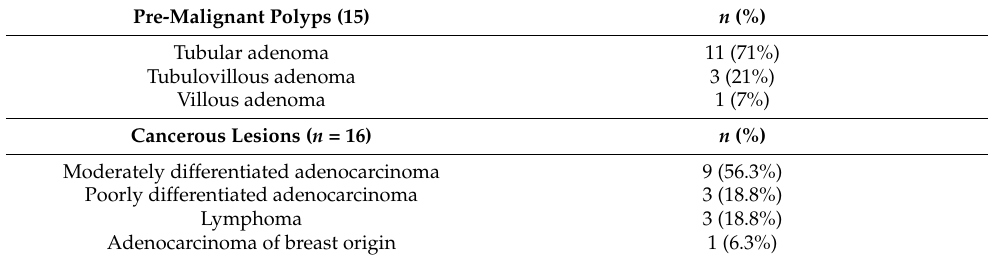
Table 3. Pre-malignant and malignant lesions found upon endoscopic investigation.